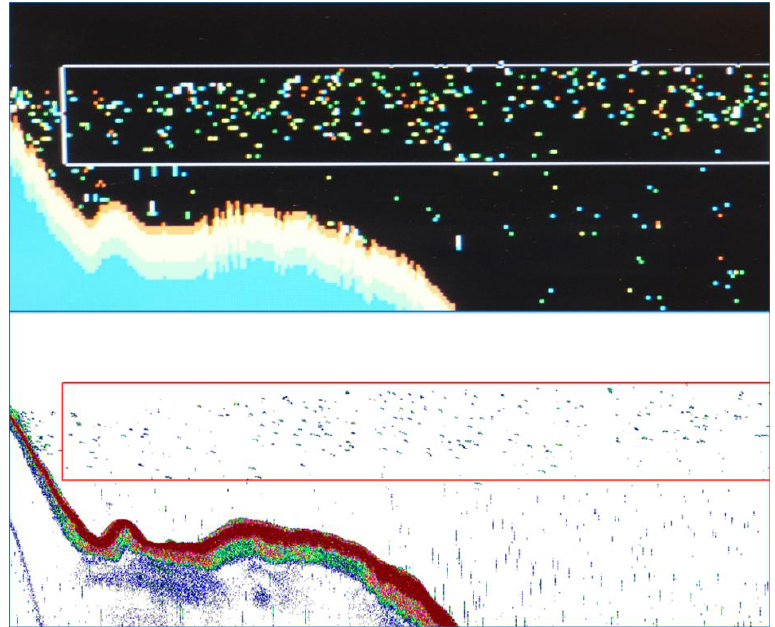
Figure 2. Echograms from Transect 2, 27.05.2016, produced by Simrad EY-M/HADAS ( above ) and by Simrad EK15/Sonar5-Pro ( below ). Horizontal lines show 20 – 47 m depth and cover an approximately 1000 m stretch (vertical spots at depths > 50 m the in the lower chart are due to noise, not fish).